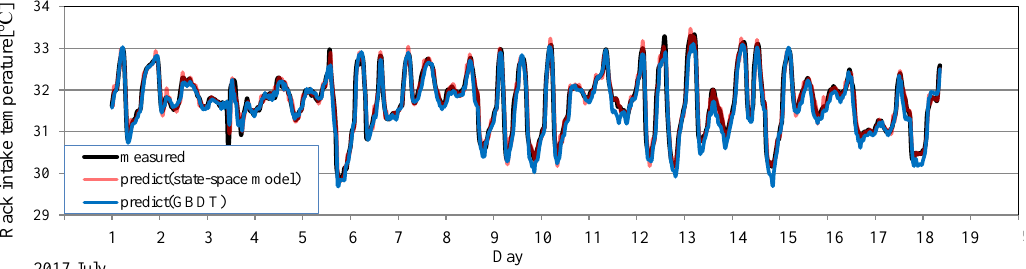
Table 9. Evaluation indices for each method (May to October 2017).